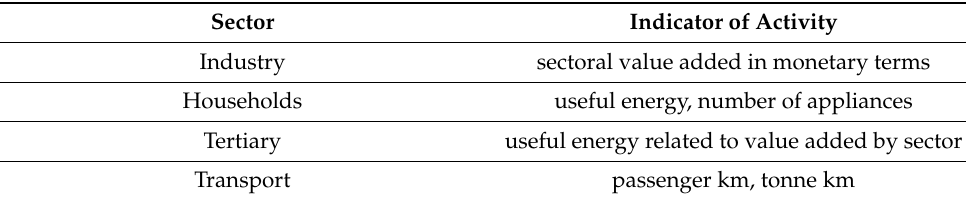
Table 2. Indicators and units of activity by sector in E3-ISL [23].